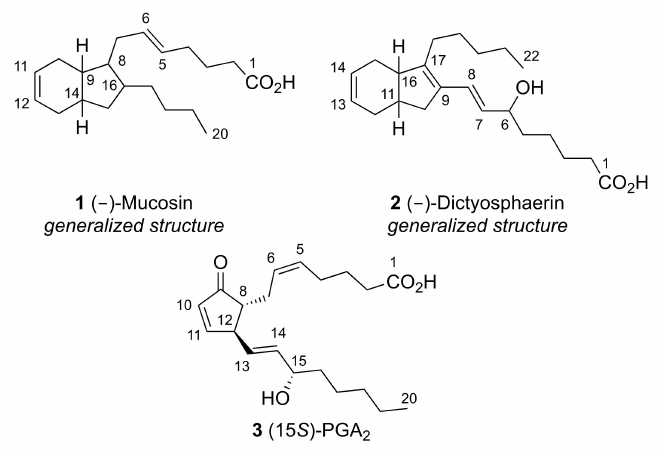
Figure 1. Generalized structures of mucosin and dictyosphaerin with a marine prostaglandin.